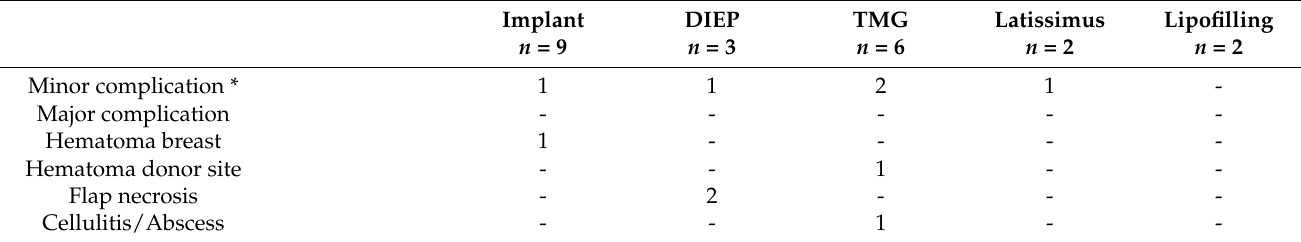
Table 4. Overview of